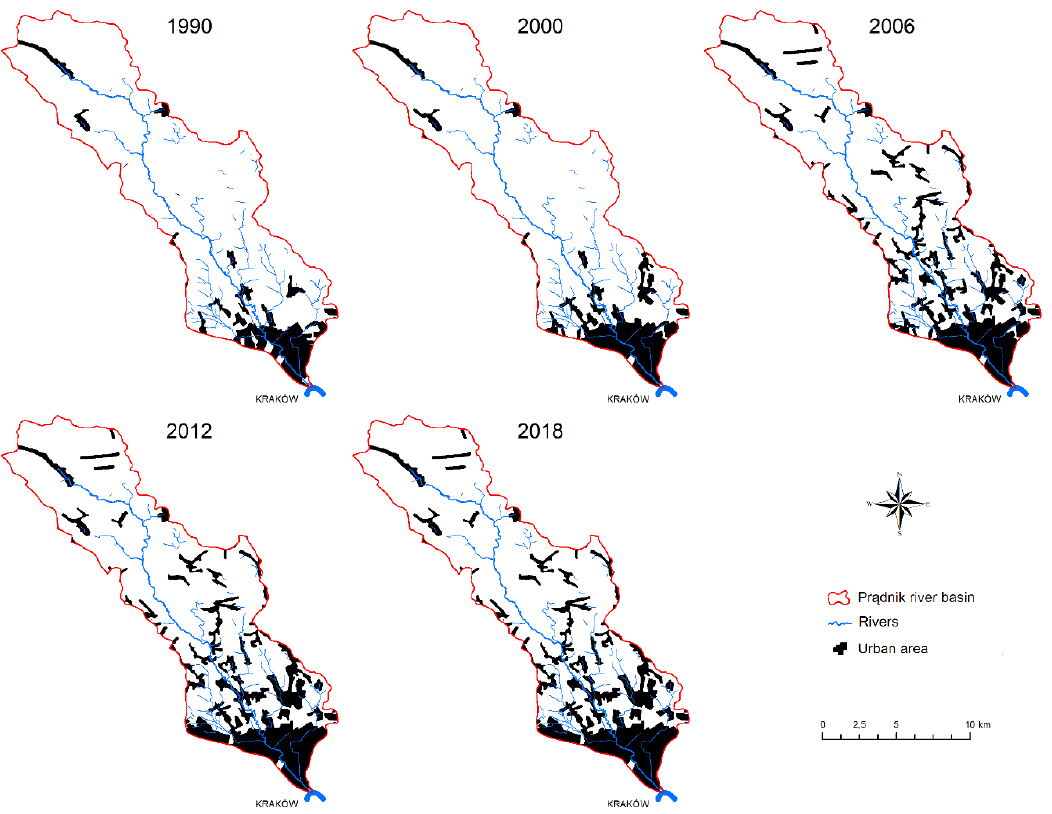
Figure 5. Urban development in the Prądnik river basin in period 1990–2018. Table 6. Change of impervious cover extent during 1990–2018, the Prądnik river basin. CORINE